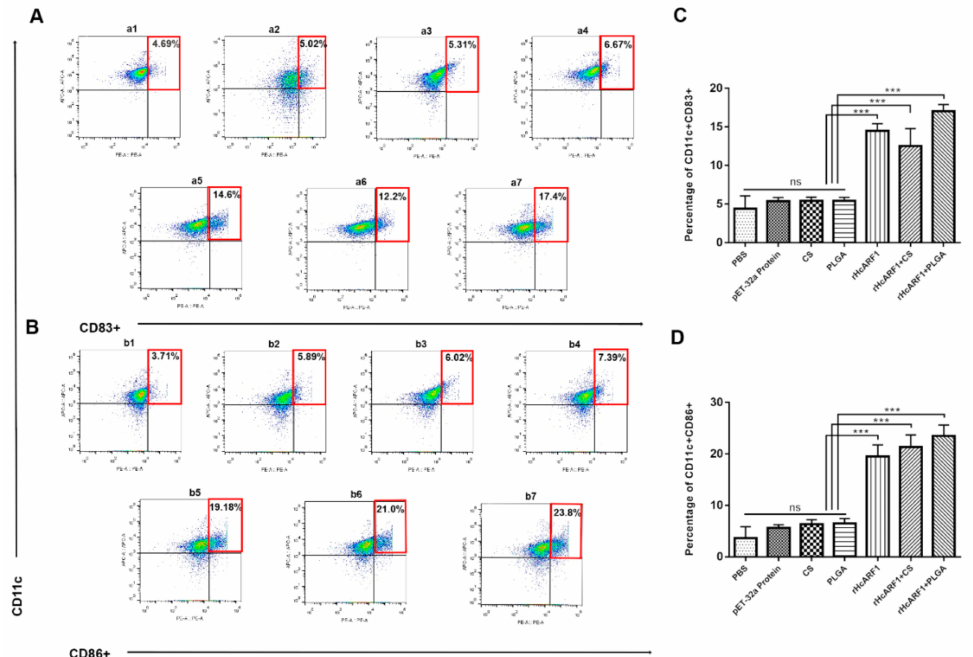
Figure 7. The e ff ect of di ff erent antigen delivery systems on the splenic dendritic cell maturation. The expression of CD83 + (( A ) ( a1 – a7 )) and CD86 + (( B ) ( b1 – b7 )) in all experimental groups on splenic dendritic cells (DC) in seven groups could be shown as dot plots (( a1 , b1 ): phosphate-bu ff ered saline (PBS) group. ( a2 , b2 ): pET-32a protein group. ( a3 , b3 ): CS group. ( a4 , b4 ): PLGA group. ( a5 , b5 ): rHcARF1 group. ( a6 , b6 ): rHcARF1 + CS group. ( a7 , b7 ): rHcARF1 + PLGA group) were examined by flow cytometry. In ( C , D ), the bar graphs display di ff erent treatments that a ff ected the proportion of CD83 + cells and CD86 + cells. The data are presented as the mean ± SEM and representative of triplicate experiments (*** p <